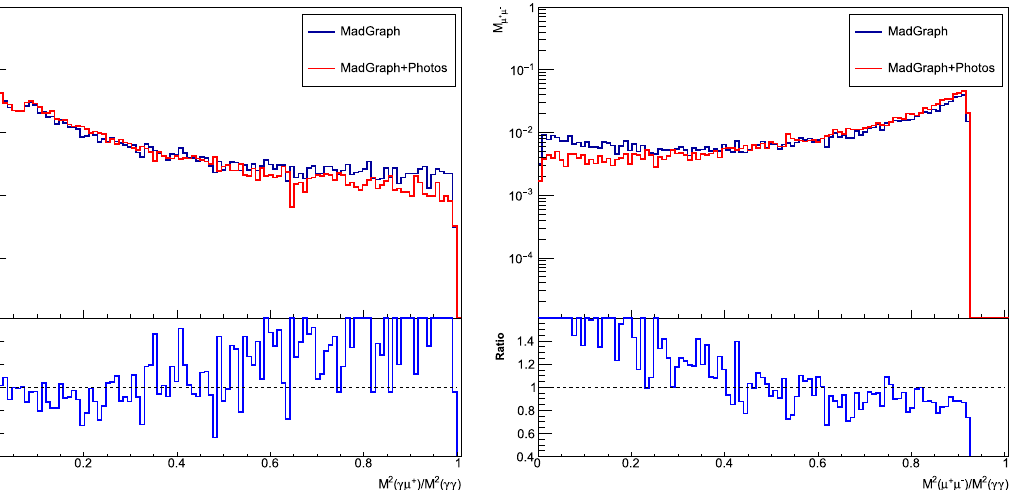
Fig. 8 The distribution of invariant mass of μ + γ (left panel) and μ − μ + (right panel) for the γγ → μ − μ + γ process. Comparison between Photos and MadGraph . For details of selection cuts see the text. Collinear and soft photon phase space regions are excluded, but all hard non-collinear photon configurations are taken into account.